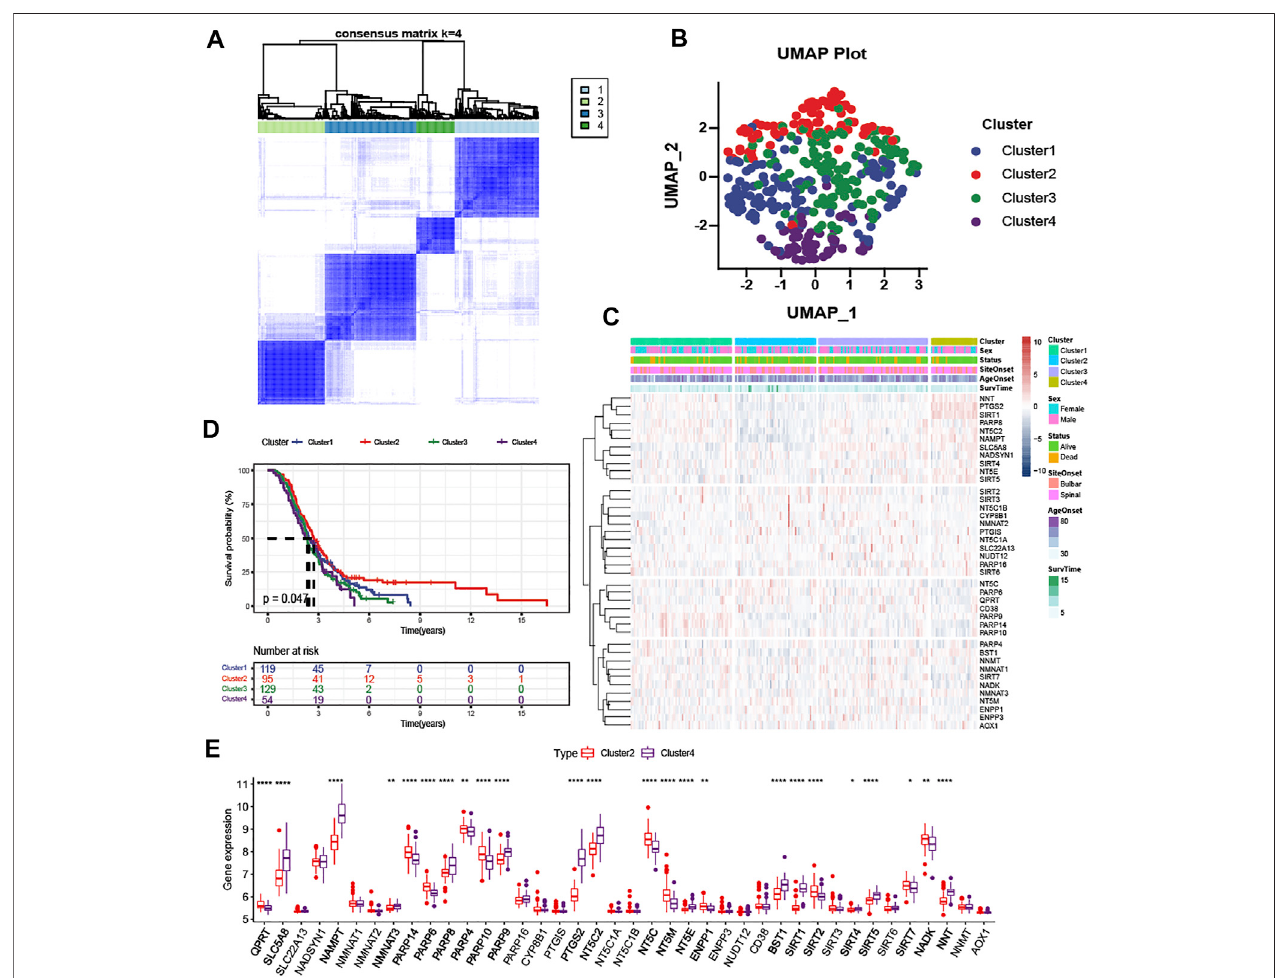
FIGURE 3 | Clustering analysis based on NAD + metabolism-related gene expression pro fi le identi fi es prognosis of ALS patients (A) Consensus clustering matrix for k = 4 (B) UMAP analysis con fi rmed the classi fi cation (C) Heatmap depicted the expression levels of NAD+ metabolism-related genes among the four subtypes (D) Kaplan-Meier survival analysis for patients with ALS in four clusters (E) Boxplots showed differential expression of NAD+ metabolism-related genes between Cluster2 and Cluster4. * p < 0.05; ** p < 0.01; *** p < 0.001, and **** p < 0.0001.